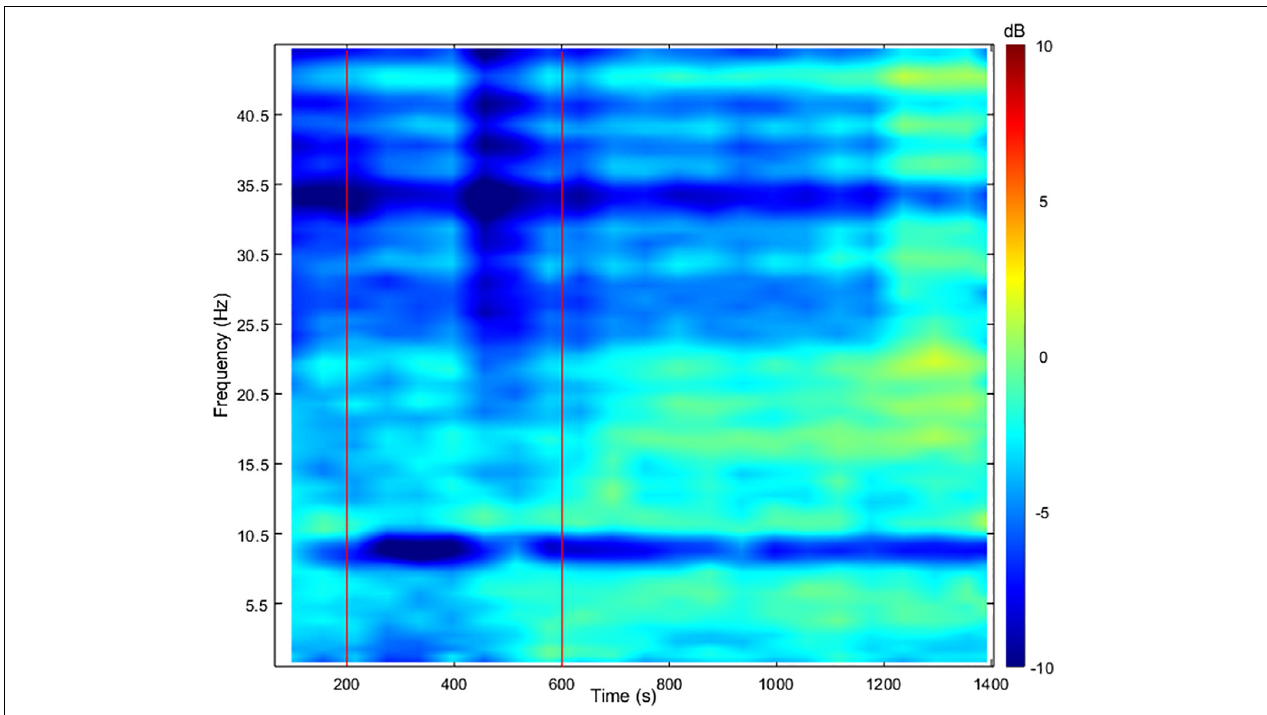
FIGURE 4 | Change in time-frequency power spectrum from baseline on the posterior (Pz) electrode. Two vertical red lines delimit the vasovagal reaction (200–600